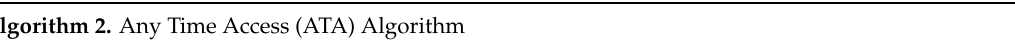
Algorithm 2. Any Time Access (ATA)